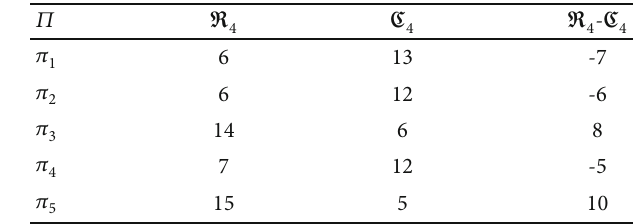
Table 12: The second negative pole membership intervals. ′′ Π − λ 1